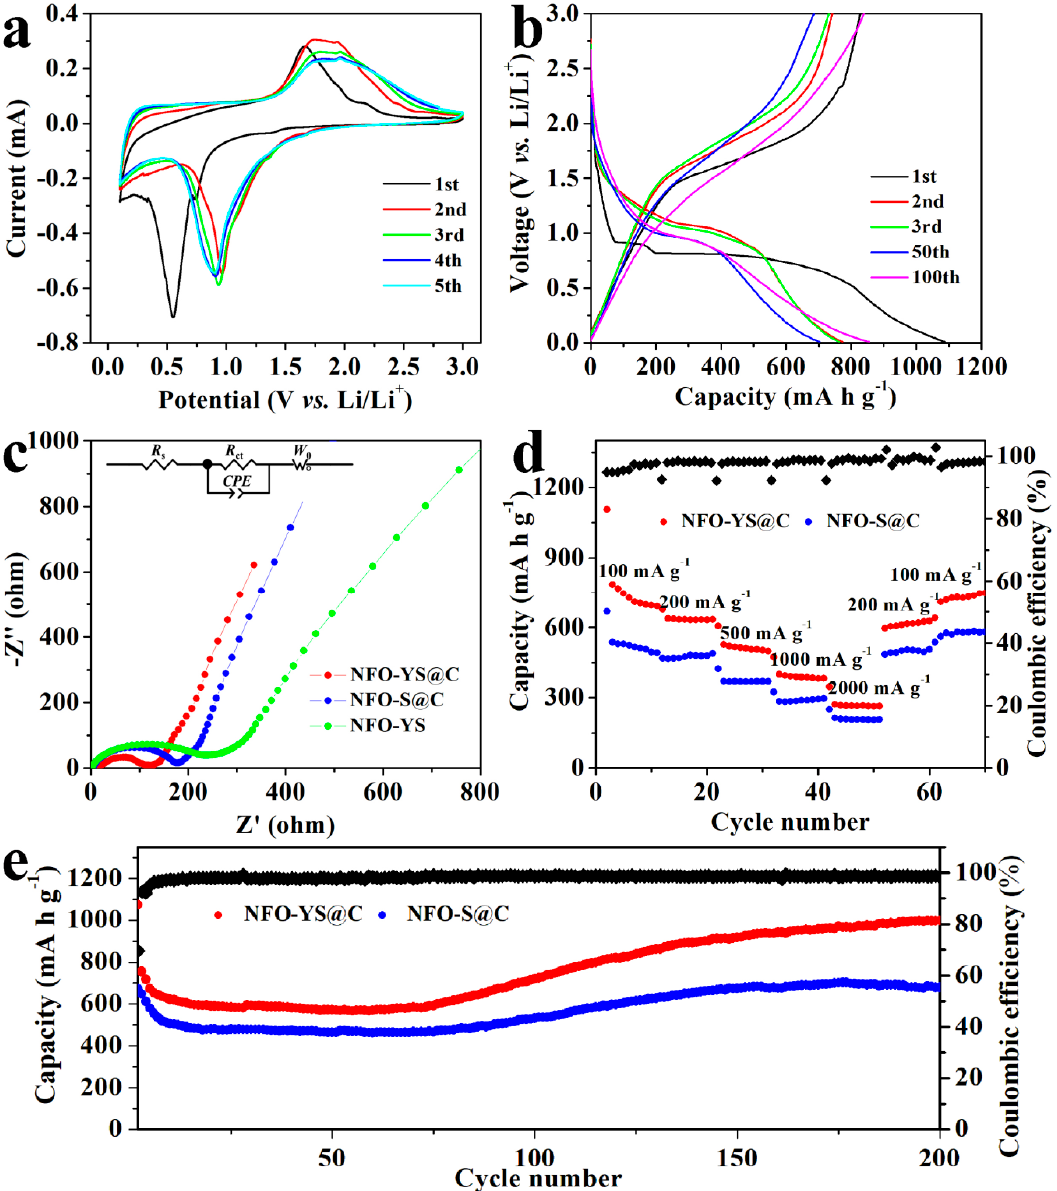
Figure 7. ( a ) CV curves of NFO-YS@C in the first five cycles; ( b ) the discharge-charge curves of NFO-YS@C at 100 mA g ‒ 1 ; ( c ) Nyquist plots of the NFO-YS, NFO-S@C, and NFO-YS@C; ( d ) rate capability of NFO-S@C and NFO-YS@C; ( e ) the cycling performances and Coulombic efficiencies at 200 mA g ‒ 1 of NFO-S @C and NFO-YS@C.